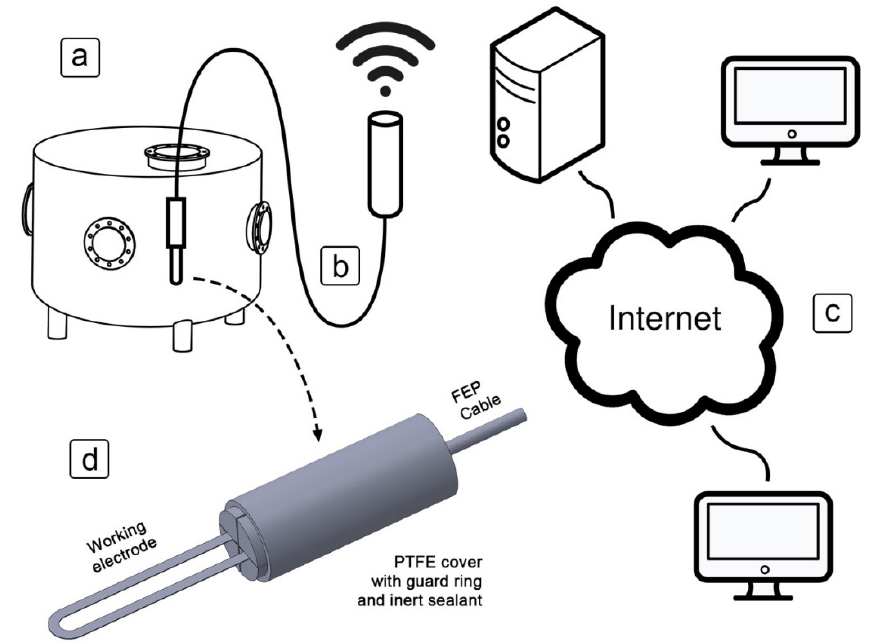
Figure 1. Schematic representation of the electrical resistance (ER) sensor: ( a ) the sensor inside an industrial boiler; ( b ) the datalogger connected to the sensor, with wireless transmission of the gathered data; ( c ) the server, which stores and serves data to end user devices over the internet; ( d ) the design of the sensor, comprising two polytetrafluoroethylene (PTFE) covers and a working electrode cut from a stainless steel sheet, with an inert sealant in between.